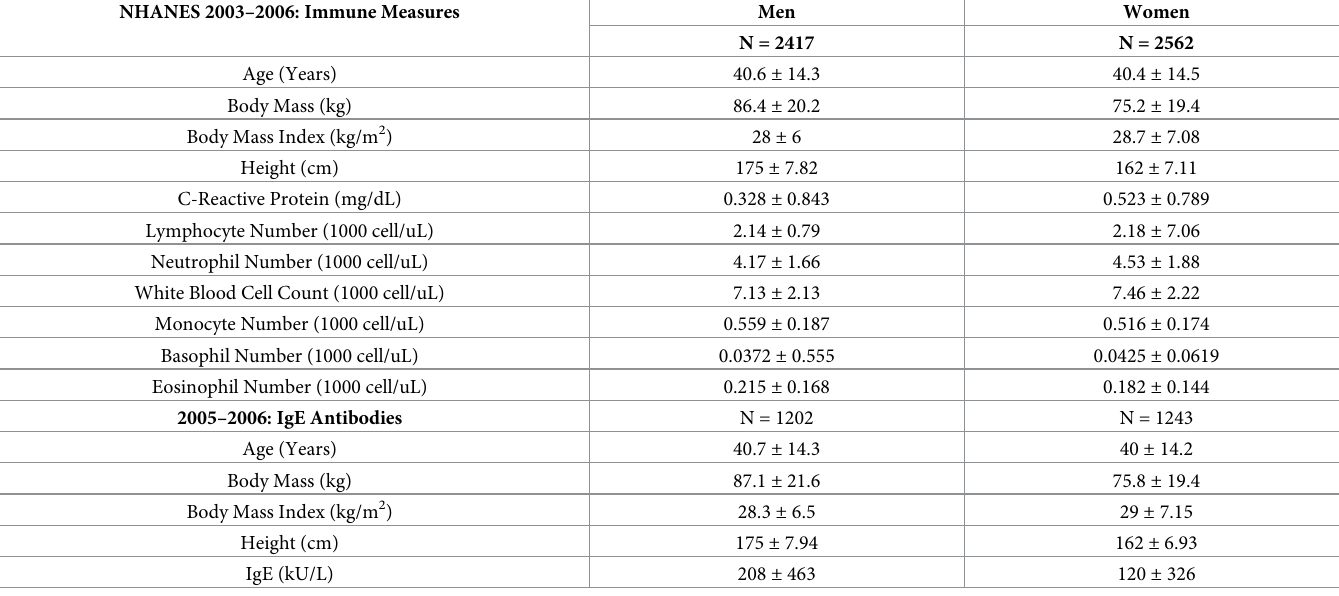
Mean ± standard deviation are shown for men and women, and sample size is provided in parentheses.